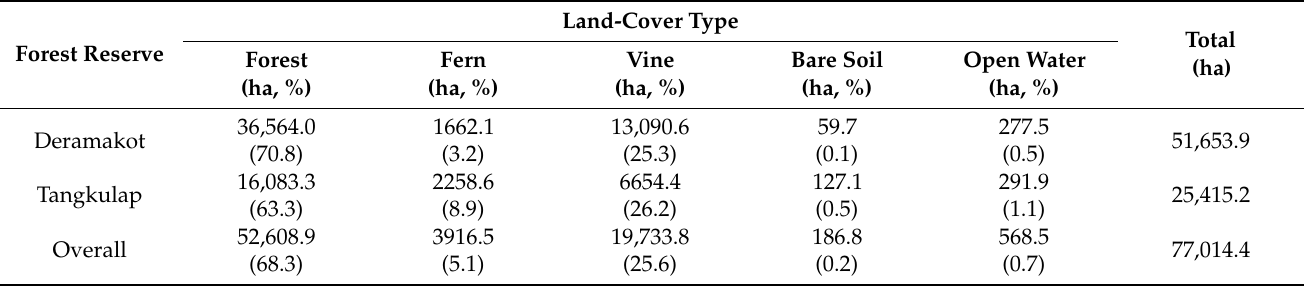
Table 4. The area of each land-cover type in Deramakot and Tangkulap Forest Reserve.